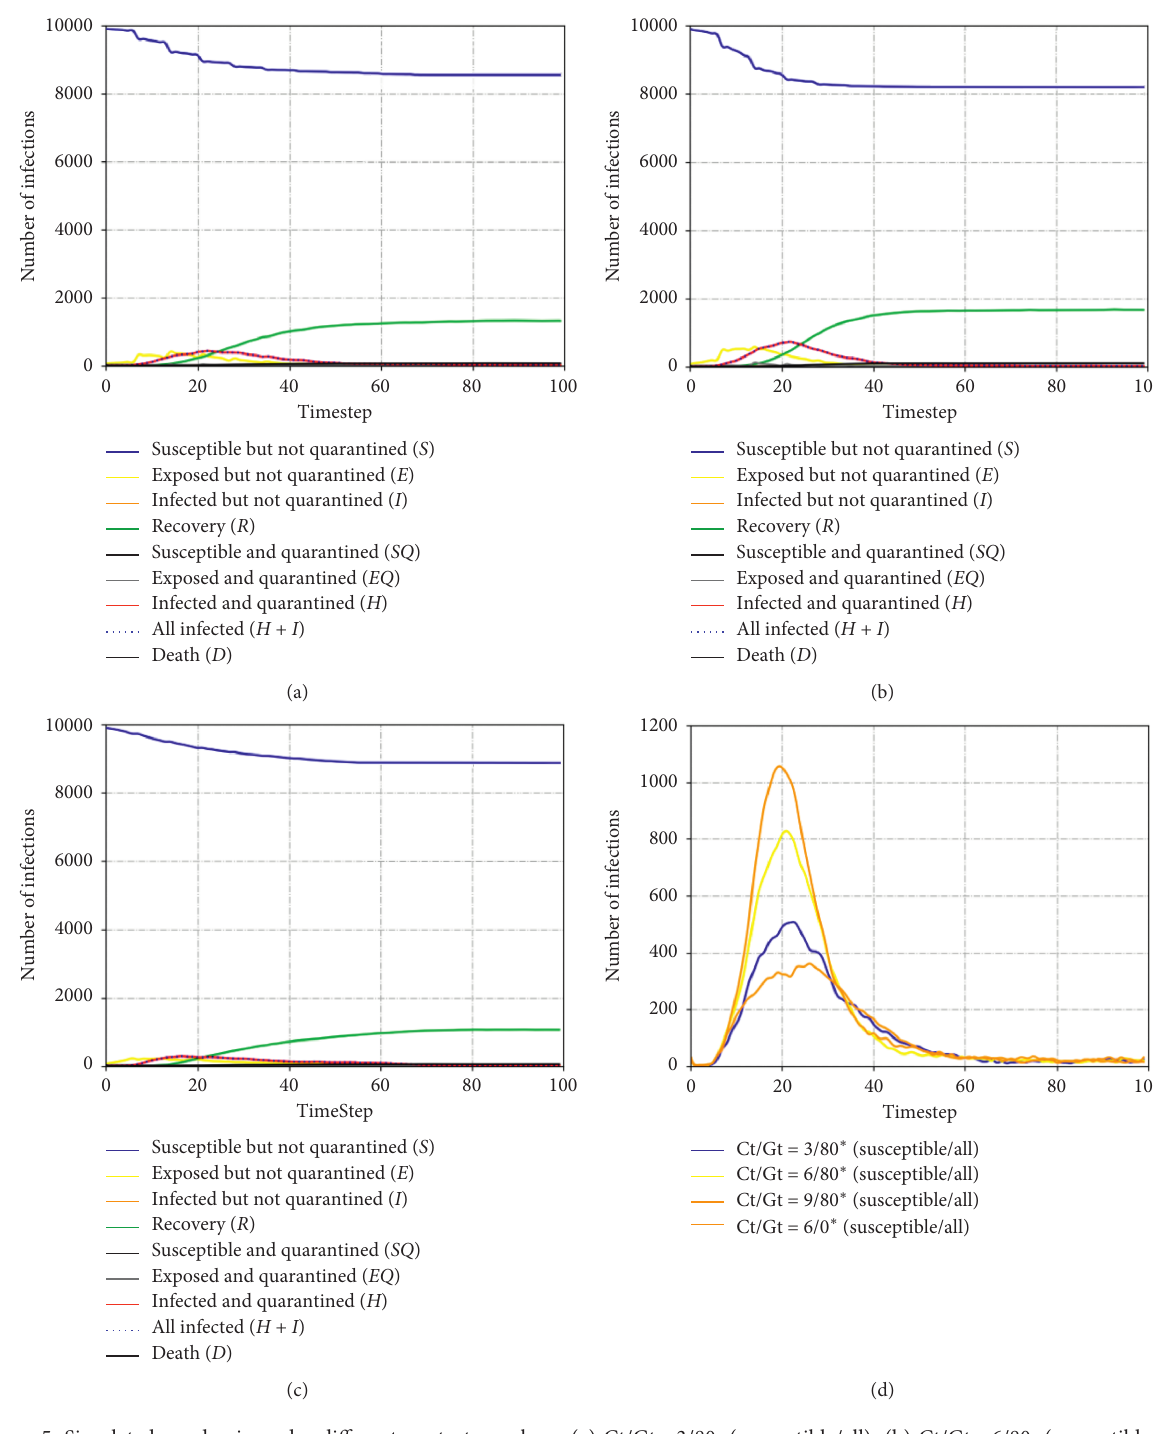
Figure 5: Simulated pandemic under different contact numbers: (a) Ct/Gt � 3/80 ∗ (susceptible/all); (b) Ct/Gt � 6/80 ∗ (susceptible/all); (c) Ct/Gt � 6/0 ∗ (susceptible/all); (d) Ct/Gt comparison